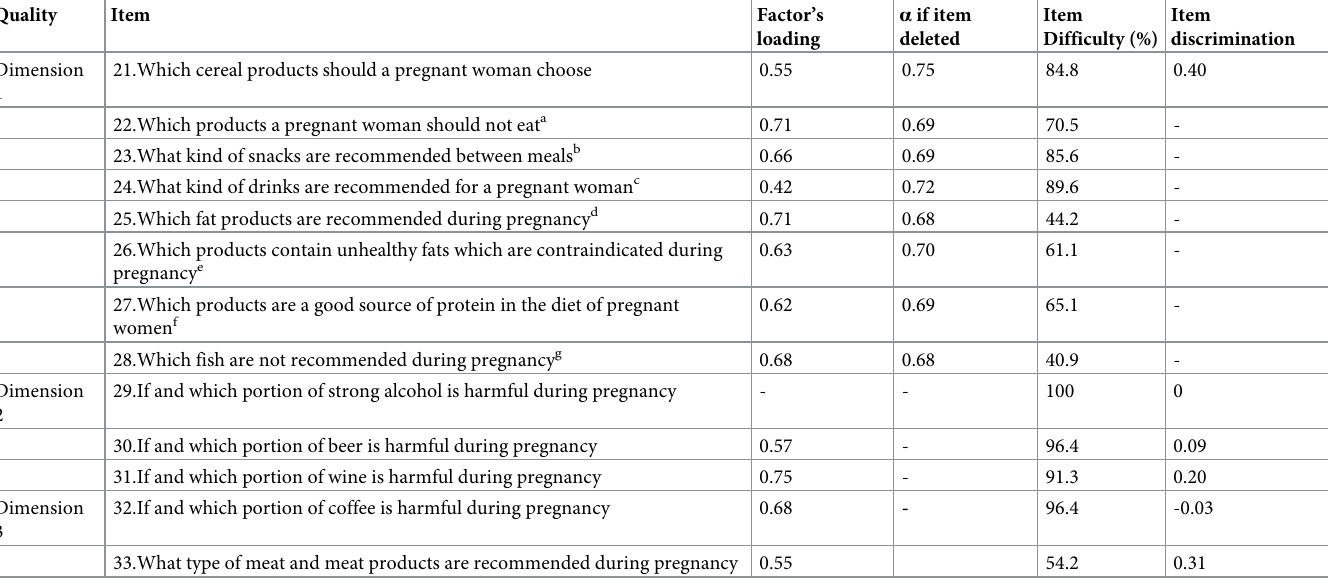
Table 7. Quality of food intake domain: Factor analysis and reliability analysis results